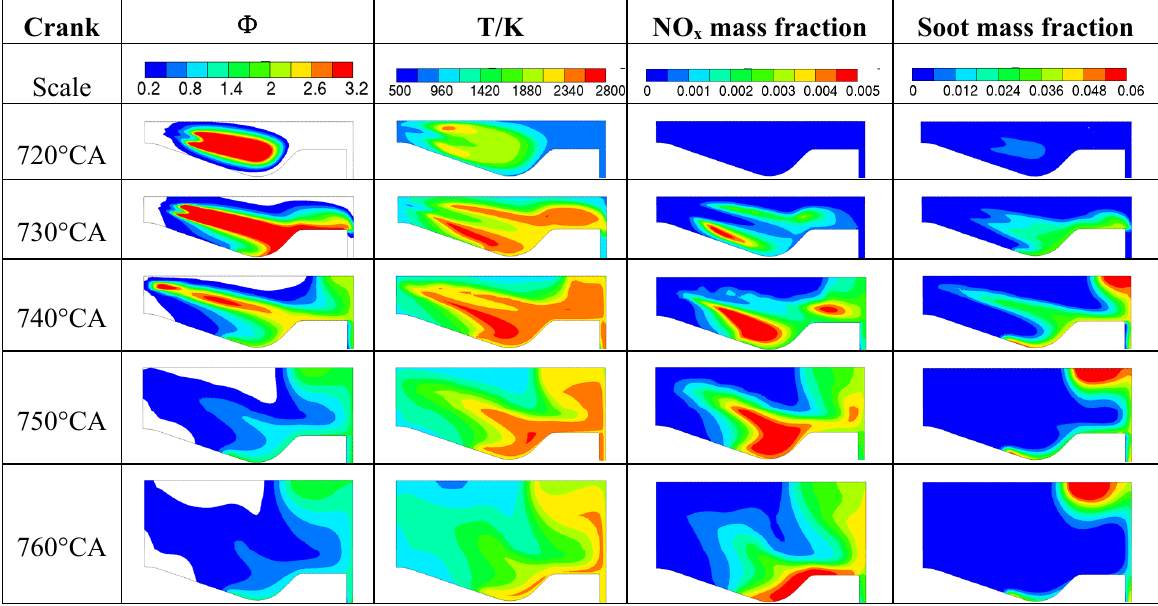
Figure 8. Contour images of equivalent ratio, temperature, NO x , and soot mass fraction of